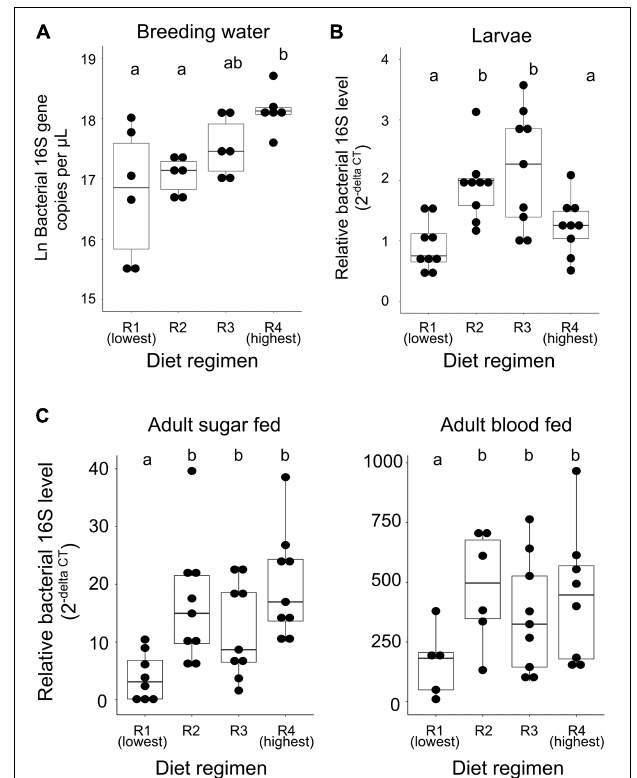
FIGURE 2 | Microbial community size is restricted by low diet availability during larval development. We reared A. aegypti larvae with varying access to larval diet (R1 = lowest abundance, R4 = highest, Table 1 ) and used 16S qPCR to quantify bacterial load in breeding water, whole larvae, sugar fed adult midguts, and blood fed adult midguts. Data were analyzed using mixed effect nested linear models to determine the effect of diet regimen on 16S level. Results of pairwise comparisons are denoted by letters above each treatment. (A) Higher diet availability results in higher 16S levels in